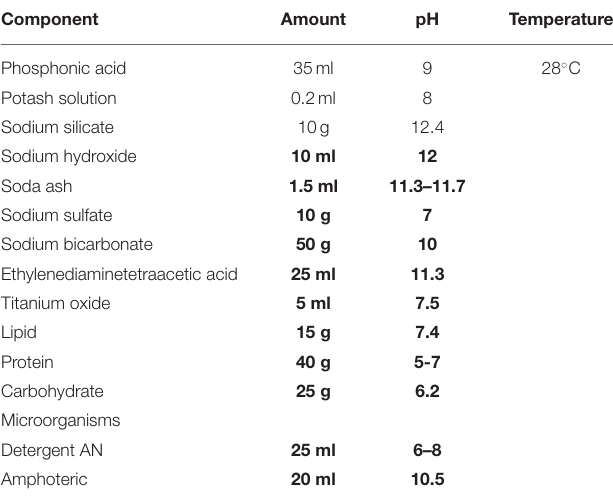
TABLE 1 | Residential building’s gray water nutrients type A-kitchen activity (washing the dishes).